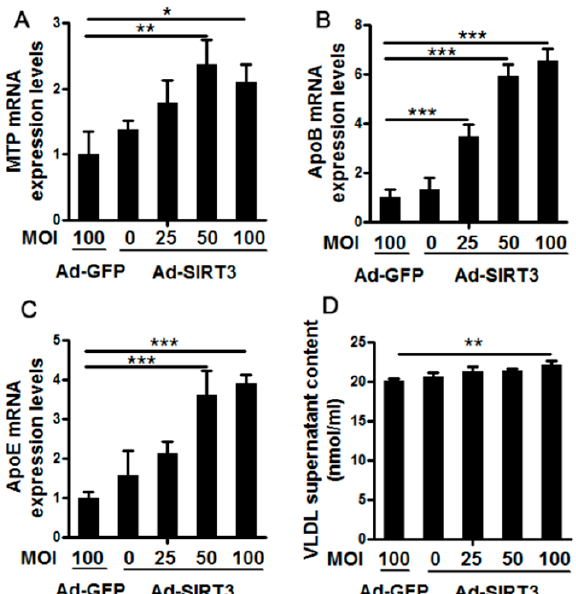
Figure 1. Effects of SIRT3 overexpression on the synthesis and secretion of Very Low-Density Lipoproteins (VLDL) in cow hepatocytes. Primary cow hepatocytes were cultured and treated with Ad-SIRT3 at 0, 25, 50, and 100 multiplicity of infection (MOI) for 6 h. Hepatocytes treated with Ad-GFP were used as the negative controls. After another 42 h of incubation with RPMI1640 medium, cells were harvested. The mRNA abundance of key proteins involved in the synthesis and assembly of VLDL, MTP ( A ), ApoB ( B ), and ApoE ( C ), were measured by qRT-PCR. The VLDL content in supernatants was measured by a commercial kit ( D ). For all bar plots shown, data are expressed as the mean ± SEM. * indicates p < 0.05; ** indicates p < 0.01; *** indicates p < 0.001 by the one-way ANOVA with Bonferroni correction. Results are representative of at least three independent meas- urements.